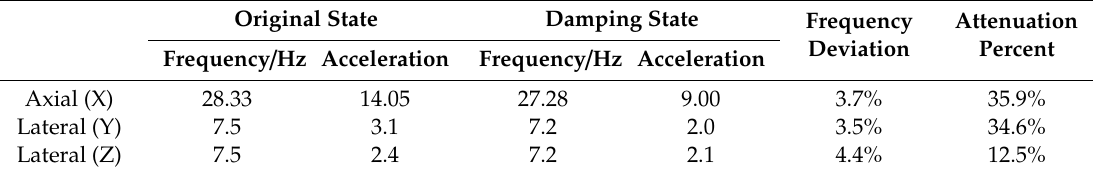
Table 6. Comparison of peak frequency and acceleration transmissibility between the original state and damping